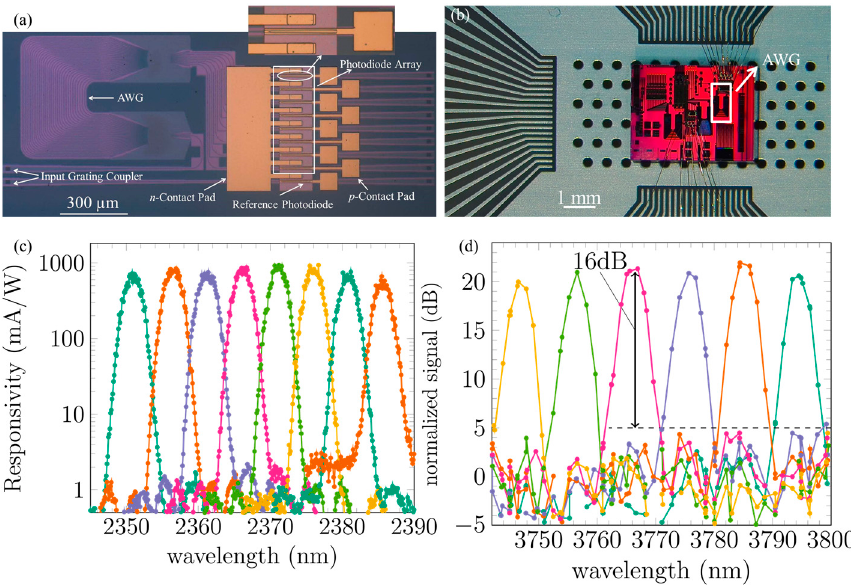
Figure 14. ( a ) Microscope image of the 2.3 μ m AWG spectrometer integrated with a InP-based type-II quantum well photodetector array; ( b ) wire bonded III–V-on-silicon AWG spectrometers on a PCB; ( c ) photo-response of the 2.3 μ m AWG and ( d ) 3.8 μ m III–V-on-silicon AWG spectrometer.